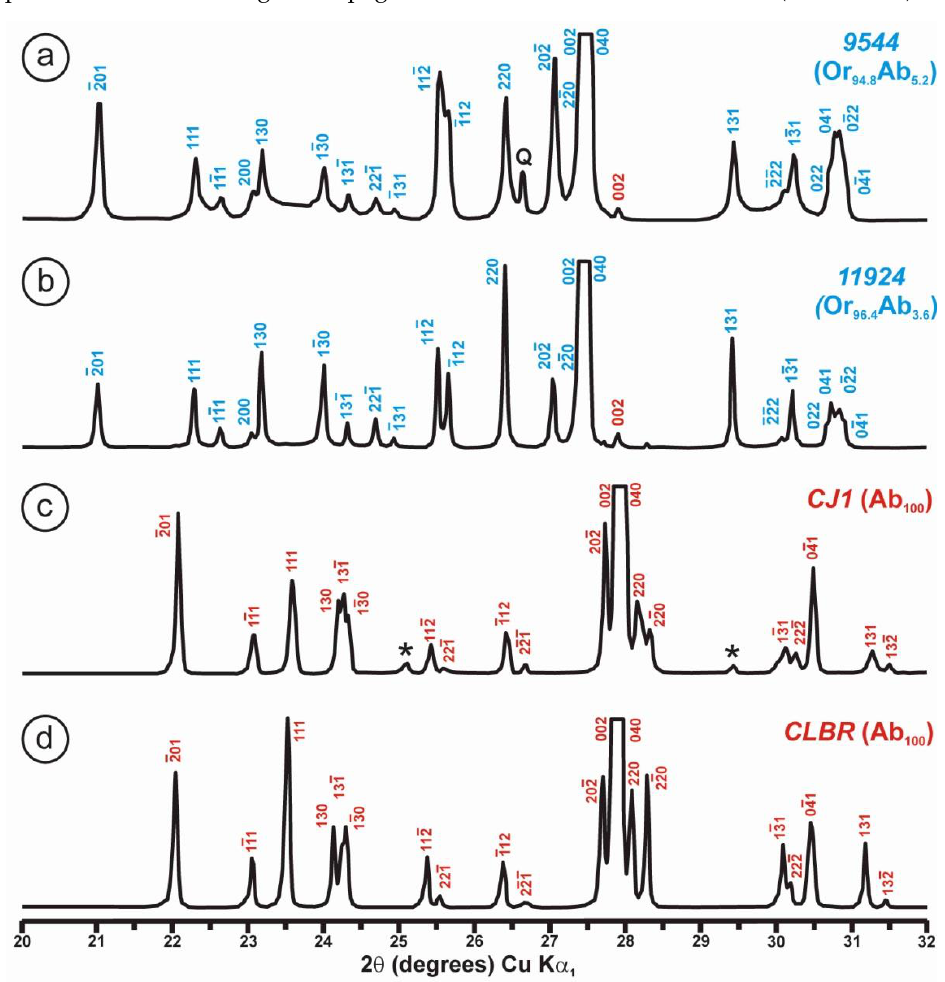
Figure 22. The powder XRD patterns between 20 and 32° 2θ CuKα 1 radiation of four specimens with chemical composition close to stoichiometry as end-members of the alkali feldspars, with (hkl) peaks in blue for “X -ray low m icrocline”, specimen 9544 in ( a ) and specimen 11924 in ( b ), both with triclinic C 1̅ space- group symmetry, and with (hkl) diffraction maxima in red for “X - ray low albite”, specimens CJ1 in ( c ) and specimen CLBR in ( d ). Q represents quartz impurities in ( a ); * for impuri- ties in ( c ); some Na-feldspar is detected in ( a ) by the (002) peak. The experimental conditions of the XRD patterns are described in [4].